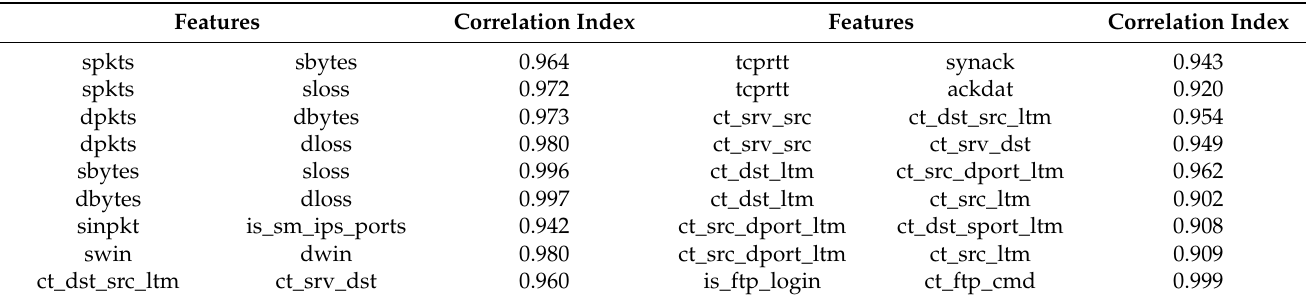
Table 7. Feature Correlation